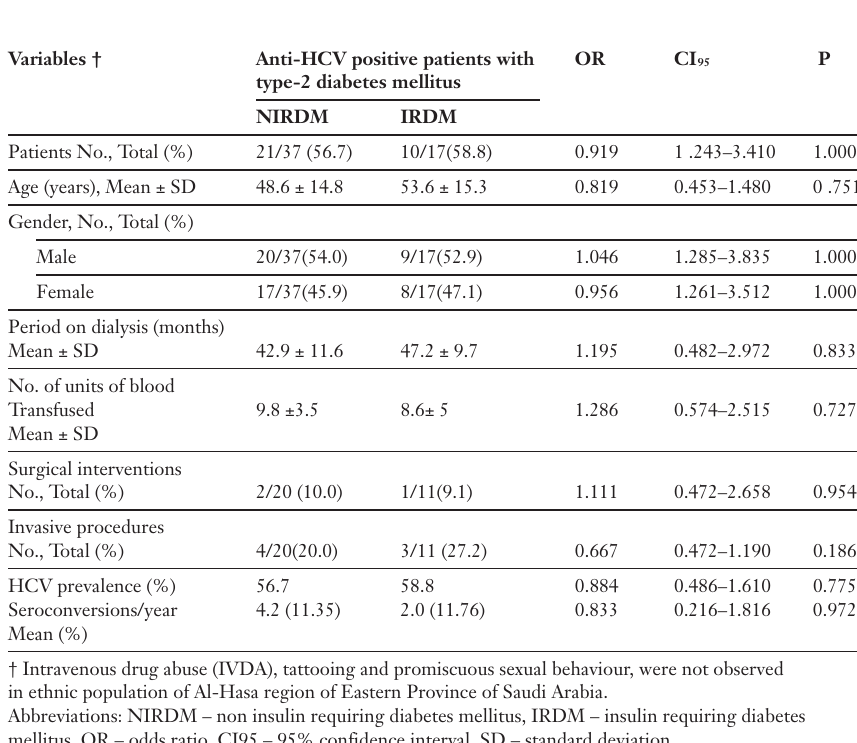
Kaplan Meier cumu- lative survival curves demonstrating the probability of HCV seroconversions in non-diabetic and Type-2 diabetic (NIRDM & IRDM) pa- tient groups on long- term HD. NIRDM – non insulin requiring diabetes mellitus, IRDM – insulin re- quiring diabetes mellitus, HR – hazard